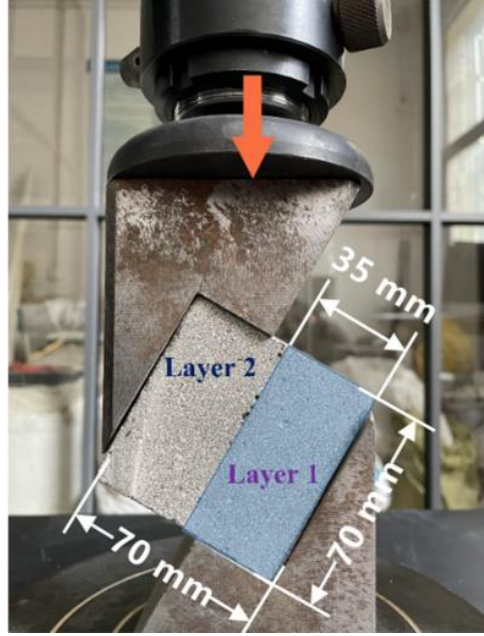
Figure 2. Measurement setup for slant shear test.